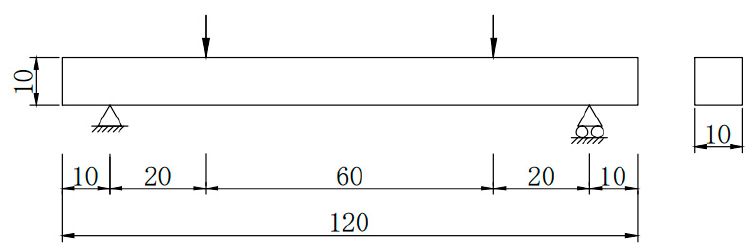
Figure 2. Numerical model of beam. The constraint on the lower left end of the beam was set as a fixed hinge support, and it constrains displacement in the x-, y-, and z-directions and rotation in the x- and y-directions. The lower right end constraint was set as a rolling hinge support, and it constrains displacement in the y- and z-directions and rotation in the x- and y-directions (Figure 3).